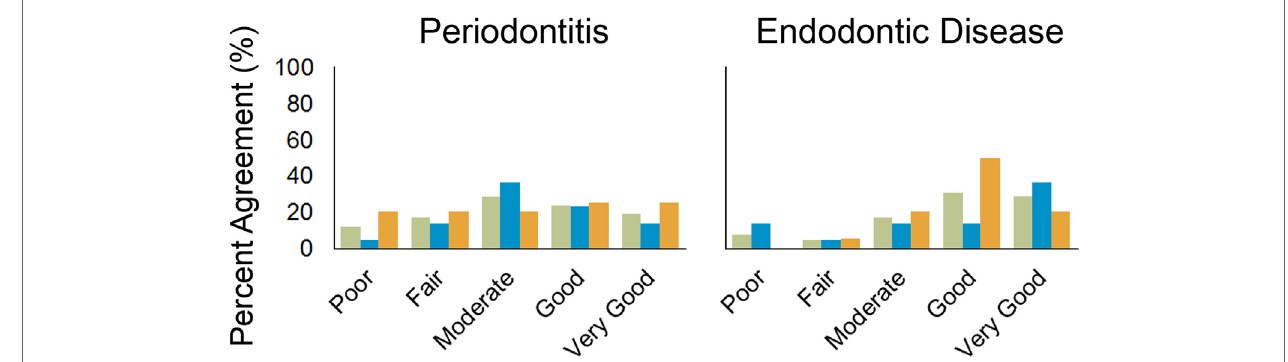
FigUre 3 | Bar chart showing percentage of agreement between intraoral radiography and cT by Observer 1 for periodontitis and endodontic disease for the entire oral cavity (green), maxillary dentition (blue), and mandibular dentition (orange)